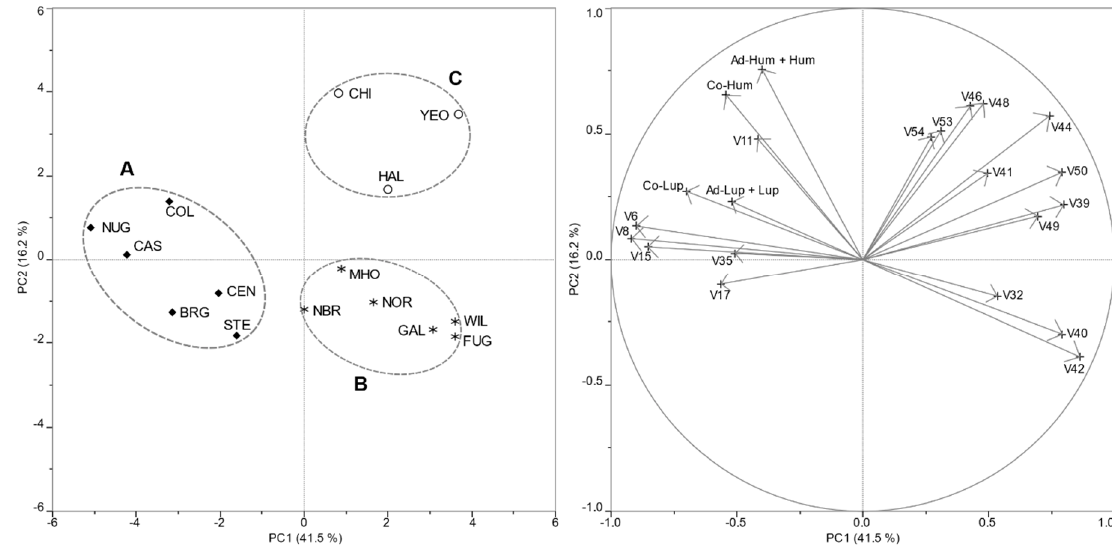
Figure 2. ( Left ) PCA scores plot of chemical data of hop cones from 15 commercial varieties of H. lupulus L. cultivated in the Marche region. Cultivar identifiers are as in Table 1; ( Right ) PCA loadings plot of variables (volatiles and acids). Identifiers of chemical substances are as in Tables 1 and 2.